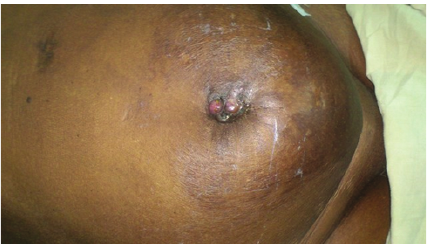
Figure 1: Umbilical fistula.